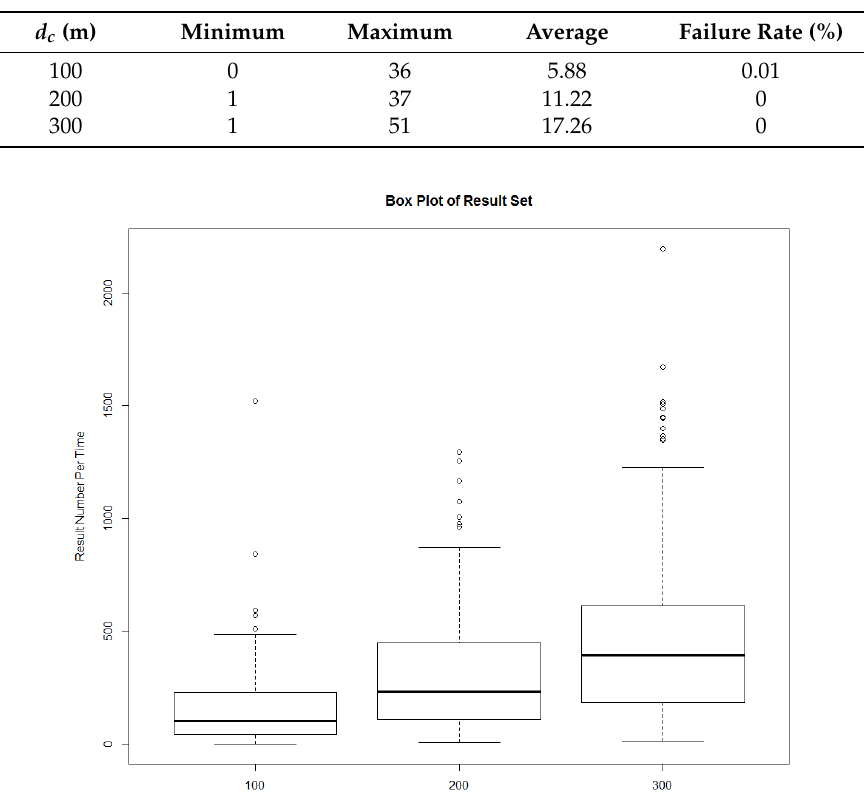
Figure 11. The number of service results.